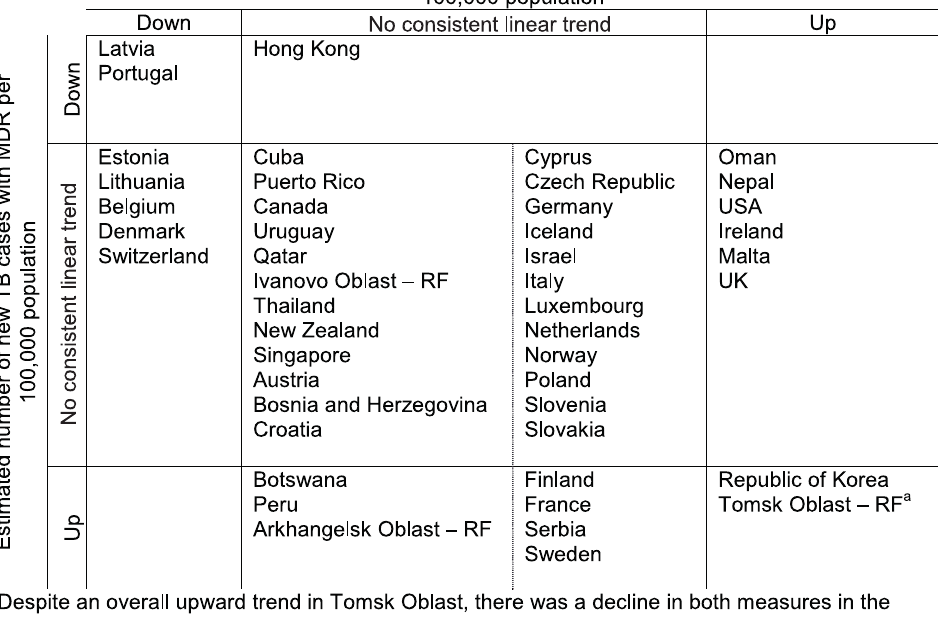
Figure 5. Trends in the number of new TB cases per 100,000 population with INH-R. Settings were included that provided at least 3 data points from 1994 to 2009. Trends were estimated for two types of INH-R: INH-R with rifampin resistance (multi-drug resistance (MDR)) and INH-R without rifampin resistance. Settings are grouped by any linear trend (p , 0.1) found (‘‘down’’ or ‘‘up’’) or ‘‘no consistent linear trend’’ if no linear trend was found. RF=Russian Federation.